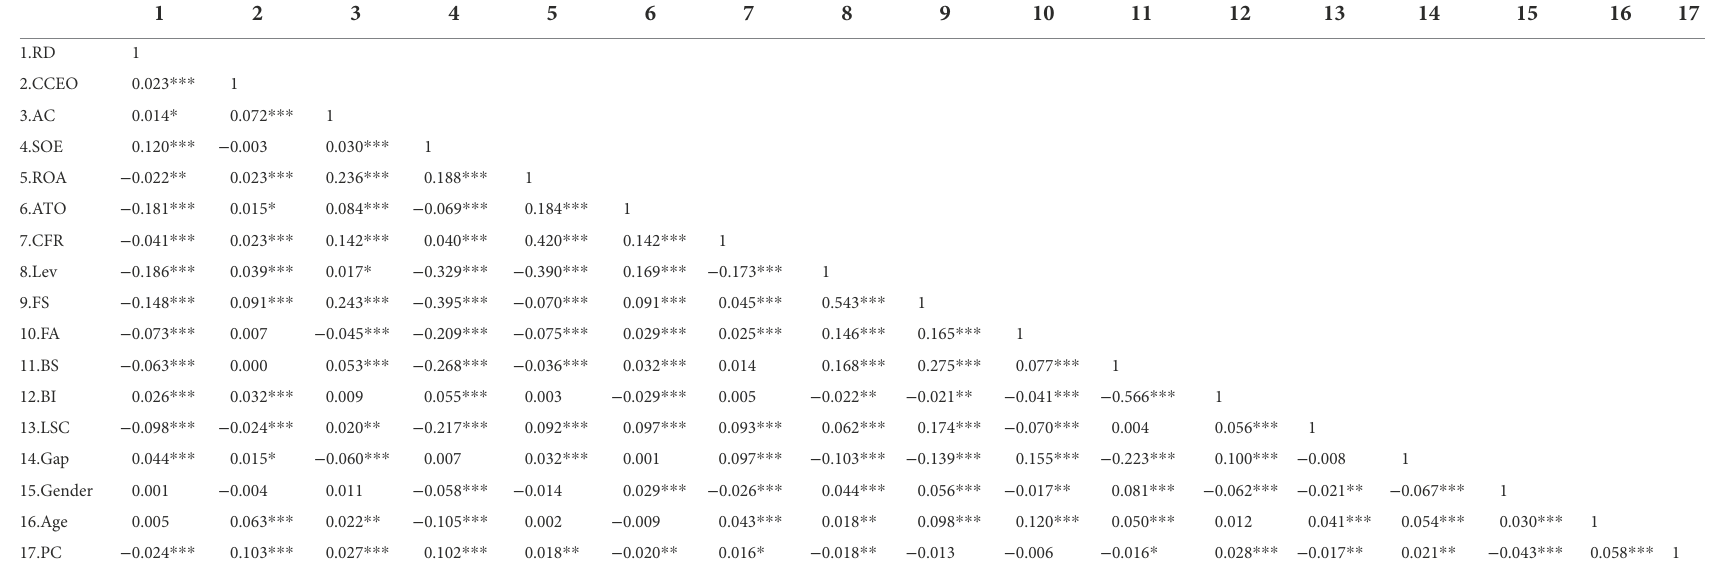
TABLE 3 Correlation analysis